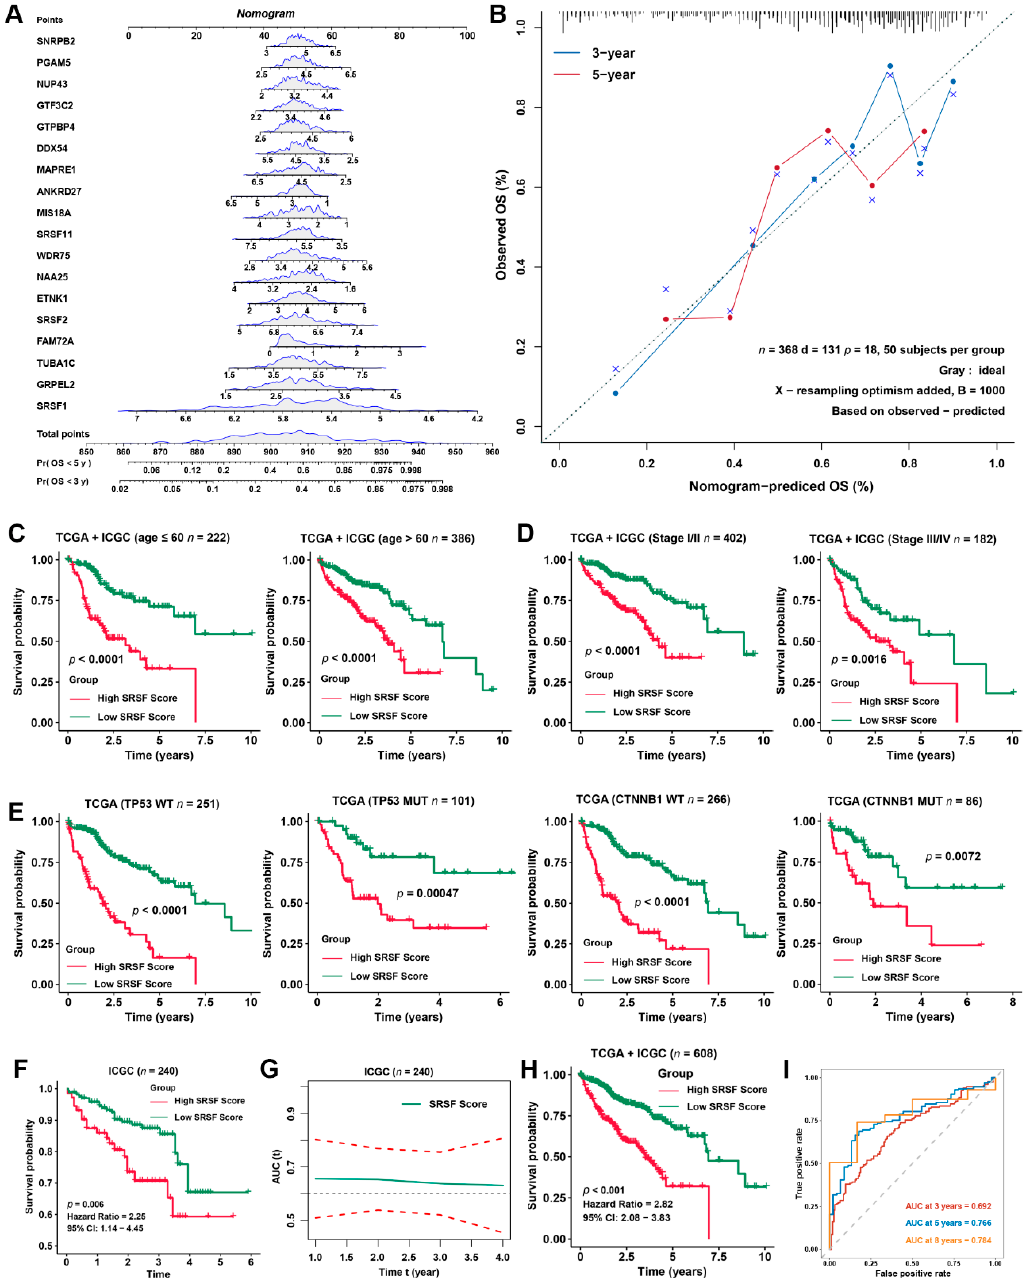
Figure 5. Validation of the prognostic predictive power of the SRSF score for HCC patients from different subgroups. ( A ) Nomogram to predict the 3- and 5-year overall survival of HCC patients. ( B ) Calibration curve for the comprehensive survival nomogram model in the TCGA-LIHC cohort. The dashed diagonal line represents the ideal situation, and the blue and red lines represent the 3- and 5-year observed nomograms, respectively. ( C ) Kaplan–Meier curves of the OS in HCC patients with different ages stratified by the SRSF score. ( D ) Kaplan–Meier curves of the OS in HCC patients with different tumor stages stratified by the SRSF score. ( E ) Kaplan–Meier curves of OS in HCC patients with different tumor mutation statuses stratified by the SRSF score. ( F ) Kaplan–Meier curves of OS in the ICGC-LIHC cohort stratified by the SRSF score. ( G ) The time-dependent AUC values of the SRSF score for the prediction of 1- to 8-year survival rates in the ICGC-LIHC cohort. ( H ) Kaplan–Meier curves of OS in the aggregated HCC cohort stratified by the SRSF score. ( I ) The time-dependent AUC values of the SRSF score for the prediction of 3-, 5- and 8-year survival rates in the aggregated HCC